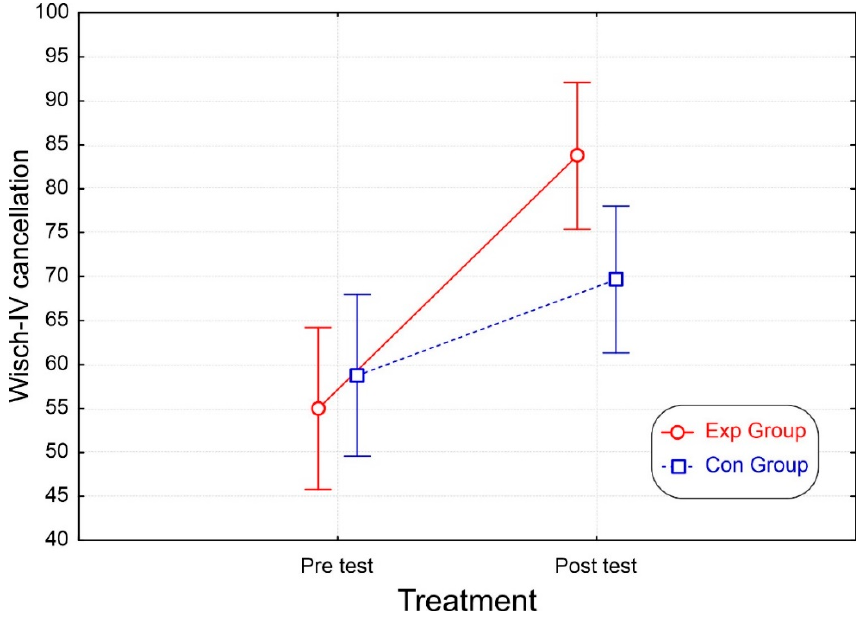
Table 3. ANOVA data of the WISC-IV cancellation. Degrees of freedom (DOF).